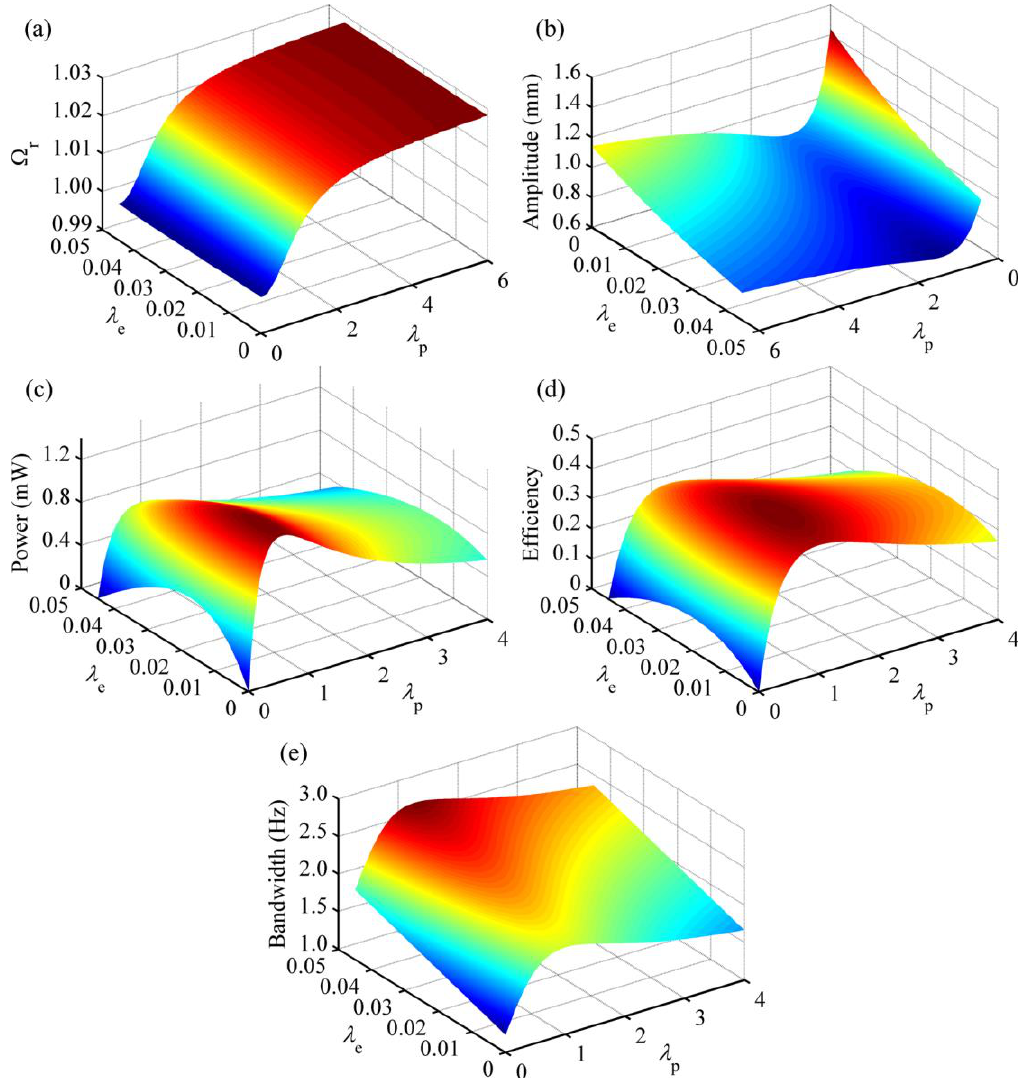
Figure 5. Performances of the HEH for different normalized load resistances λ p and λ e : ( a ) normalized resonant frequency Ω r ; ( b ) free-end displacement amplitude of the piezoelectric beam at the resonant frequency; ( c ) output power; ( d ) energy conversion efficiency; ( e ) operating frequency bandwidth.